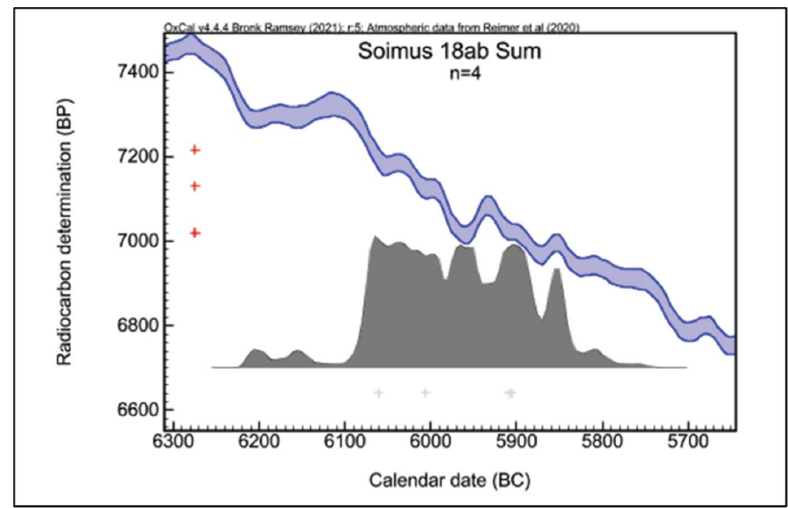
Figure 7. Sum of the AMS data coming from the features C.18a and C.18b.